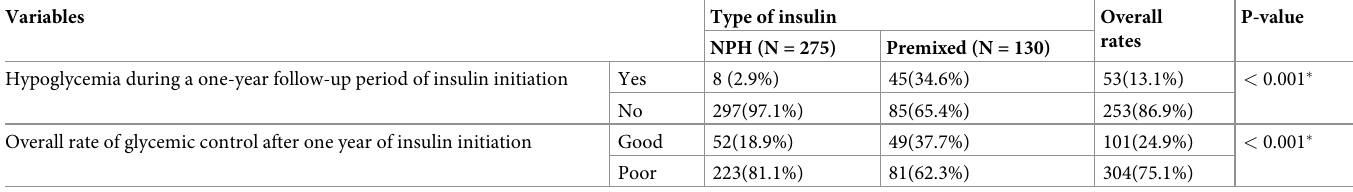
Table 4. The rate of hypoglycemia and glycemic control between NPH and premixed insulin regimens. Variables Type of insulin Overall